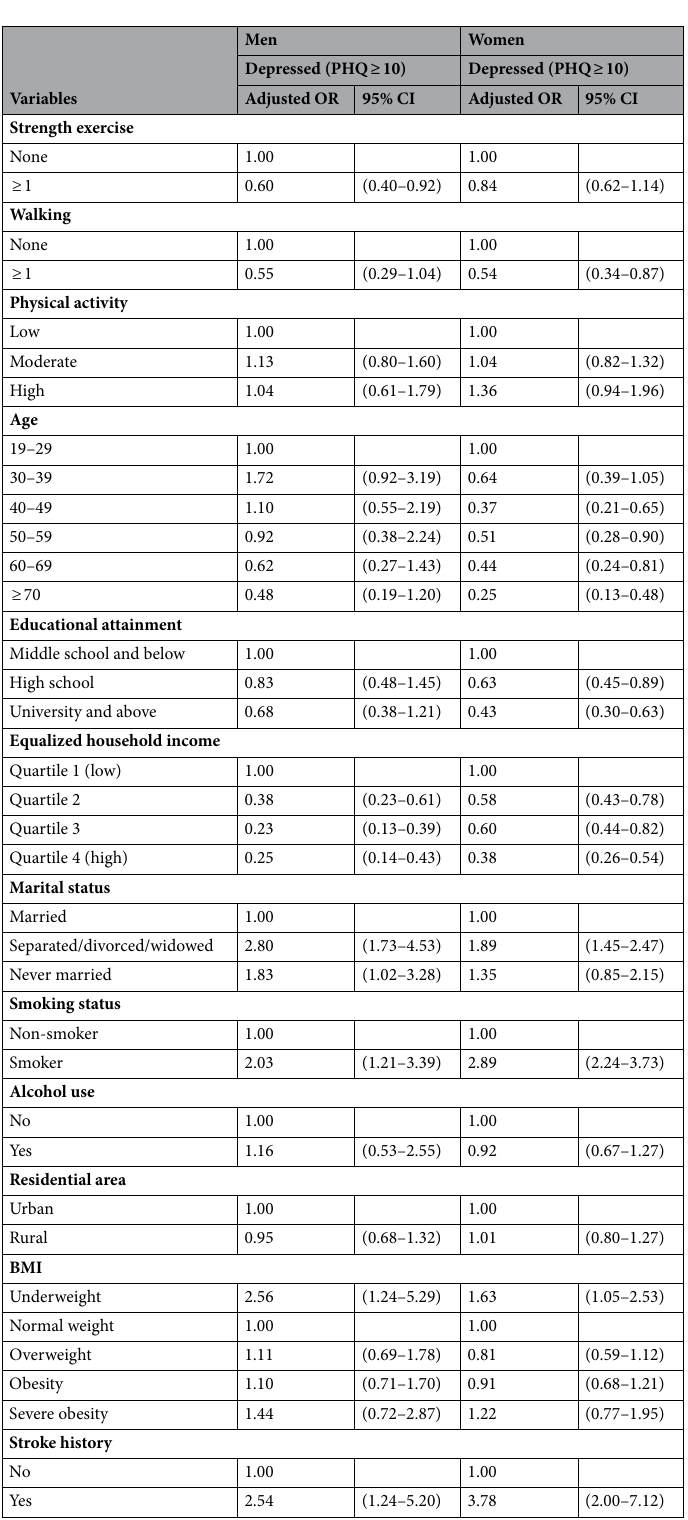
Table 2. Results of the multivariate logistic regression analysis on the association between exercise types and depression. PHQ-9 patient health questionnaire-9, BMI body mass index, Underweight BMI < 18.5,